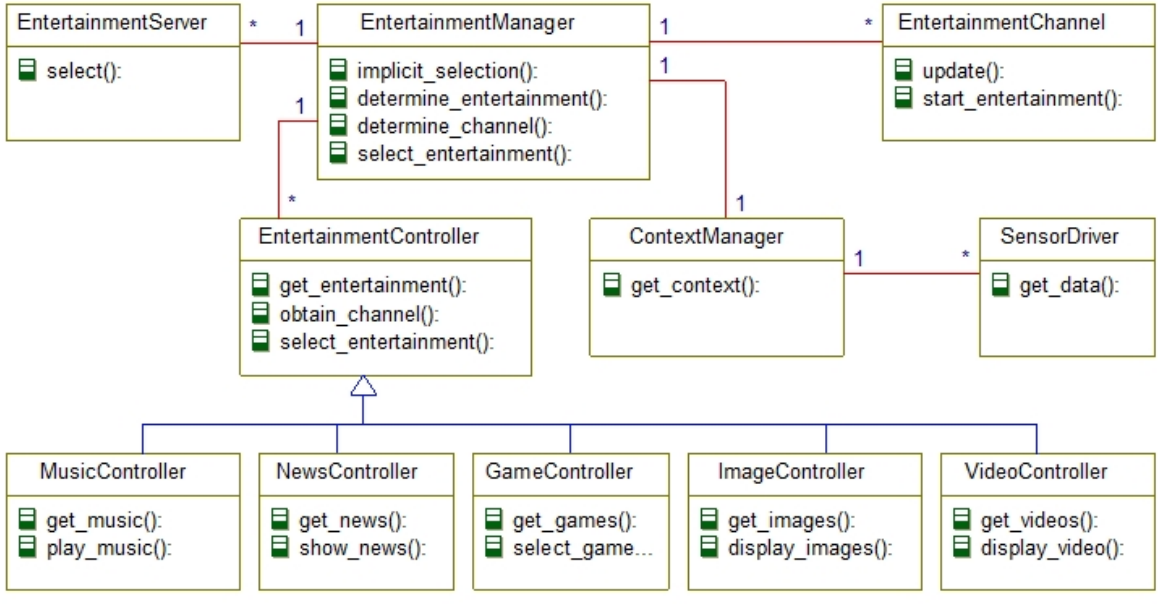
Figure 2. The object model of the proposed elderly entertainment